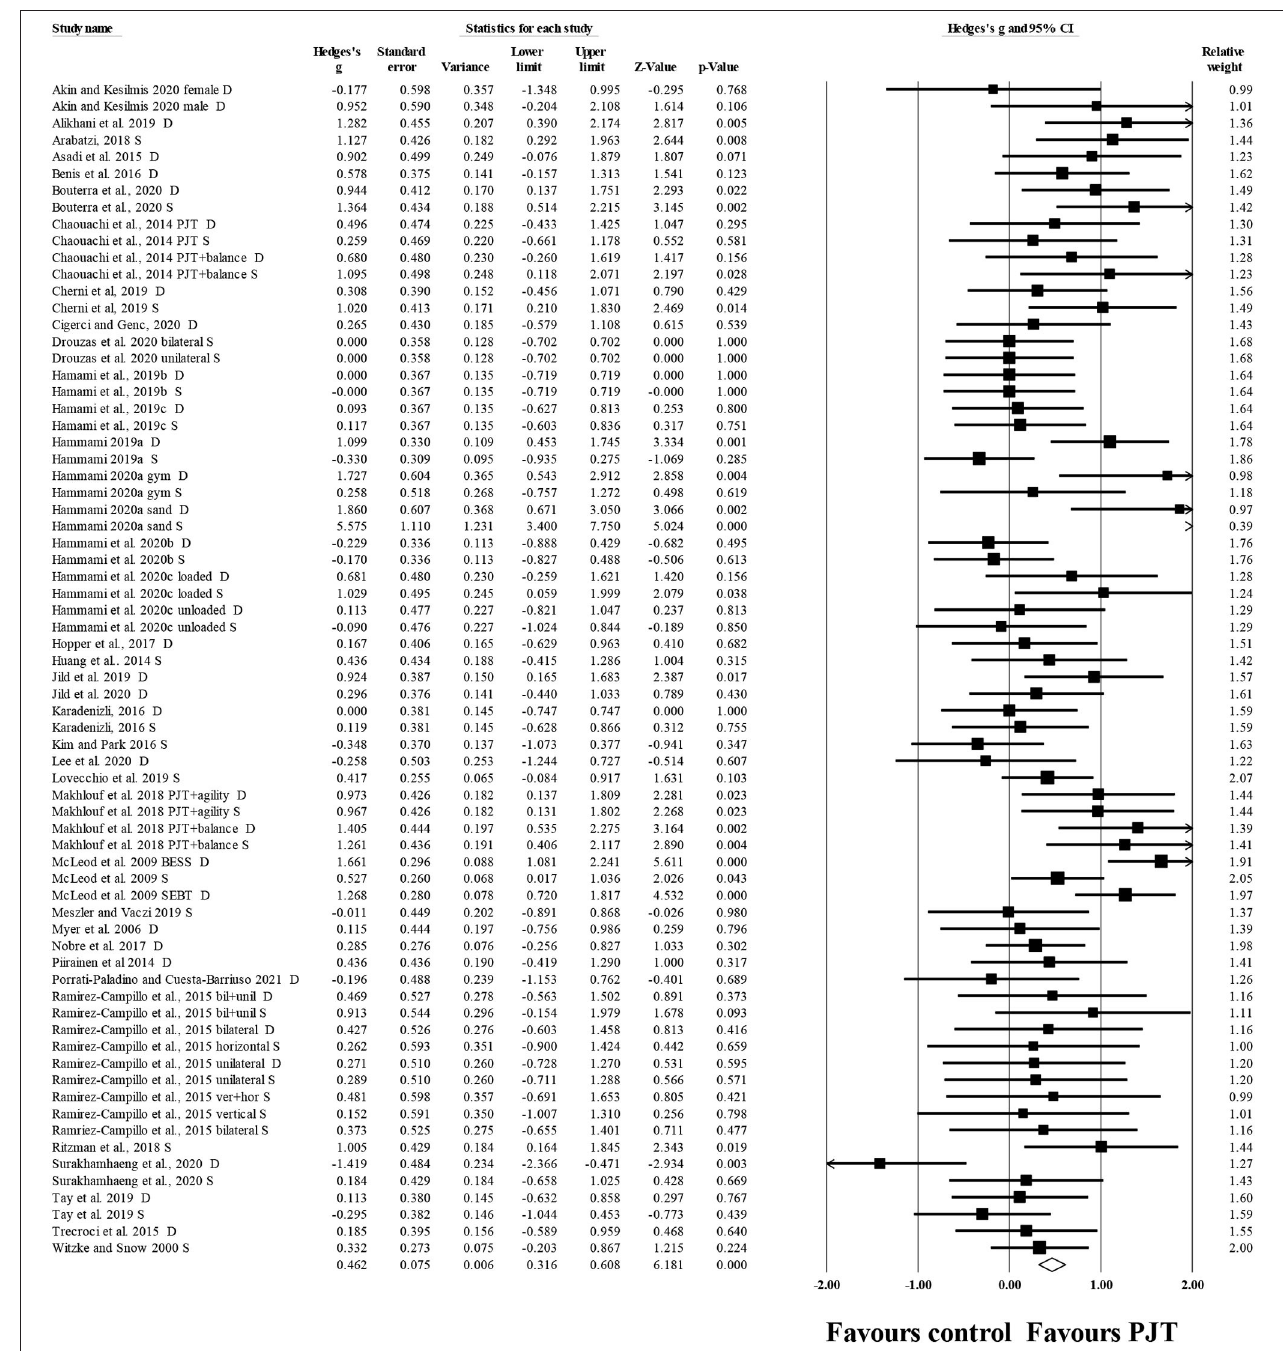
FIGURE 2 | Forest plot of changes in overall balance (i.e., all dynamic and static tests included) in participants that completed a plyometric jump training (PJT) program compared to participants allocated as controls. Values shown are effect sizes (Hedges’s g) with 95% confidence intervals (CI). The size of the plotted squares reflects the statistical weight of each study. The diamond reflects the overall